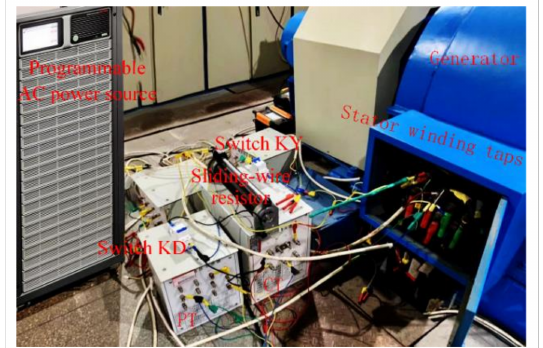
Figure 7. A photo of the dynamic experimental